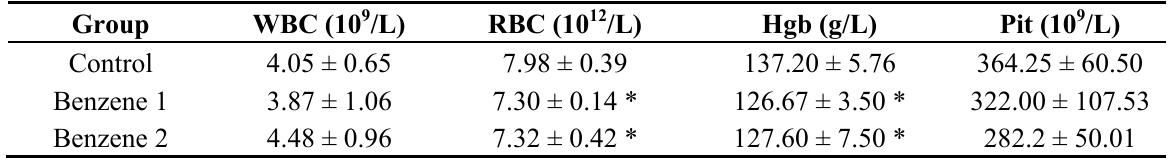
Table 2. Blood parameters in male C3H/He mice on benzene exposure day